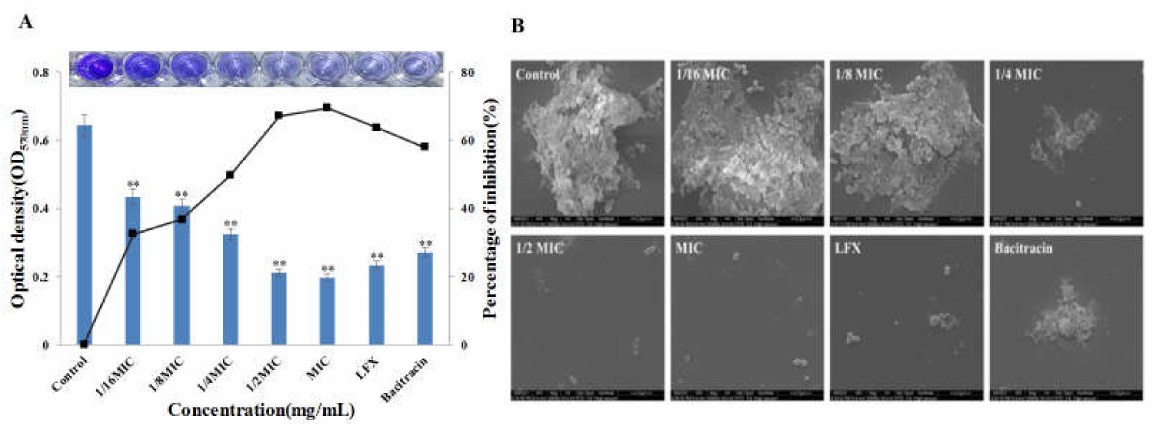
Figure 6. ( A ) Crystal violet quantitative assay for the effect of Bacitracin-AgNCs against S. flexneri biofilm formation. ( B ) ESEM images of the effects of Bacitracin-AgNCs on S. flexneri biofilm formation. ** Statistically significant differences ( p <